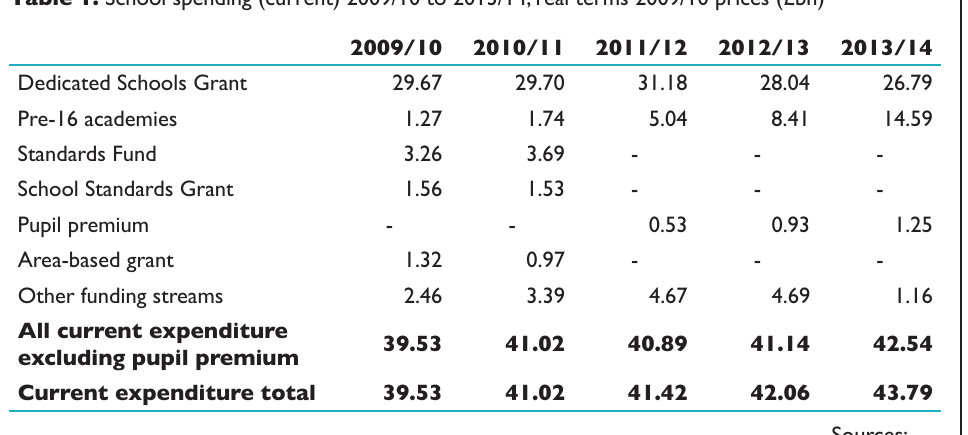
Table 1: School spending (current) 2009/10 to 2013/14, real terms 2009/10 prices